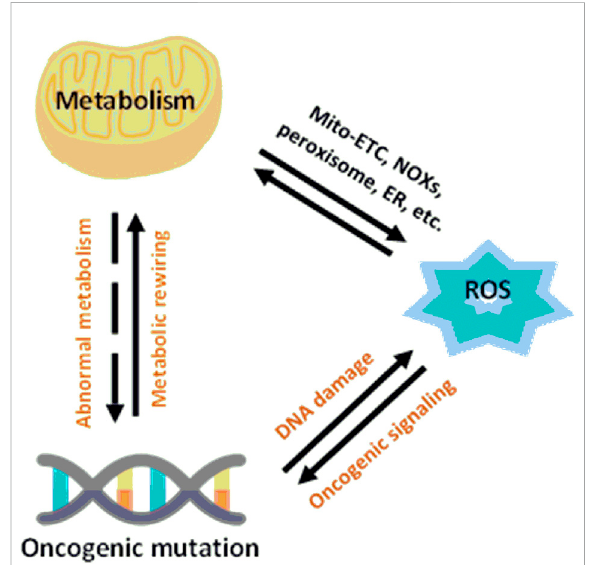
FIGURE 5 Relationship between redox state of glutathione and regulation of cell function and cell detoxi fi cation (Montero and Jassem,